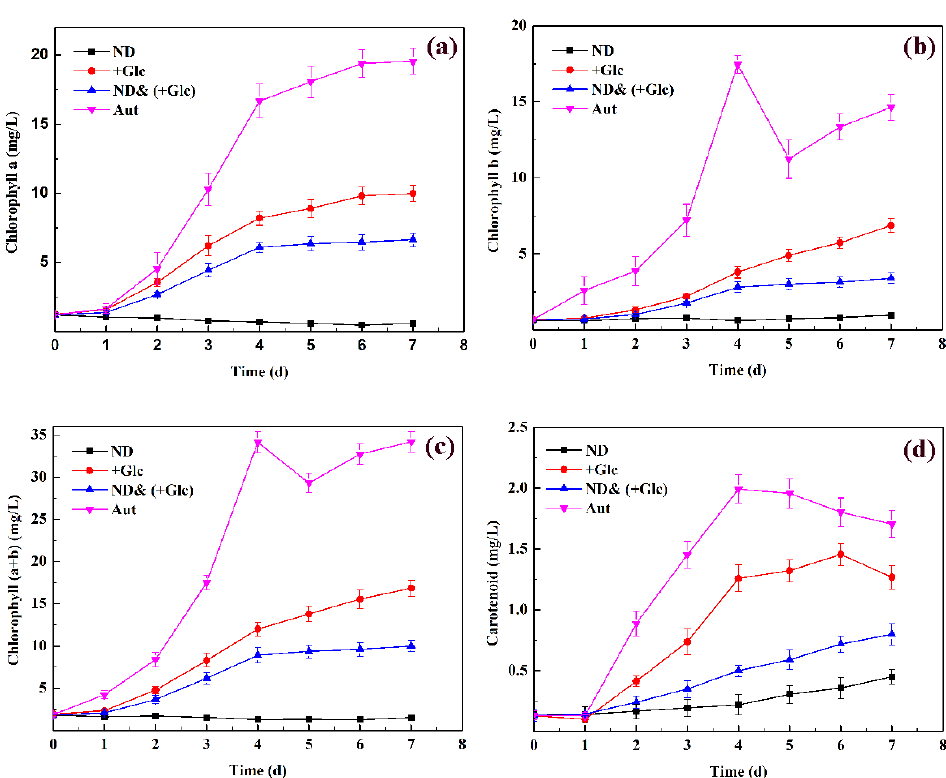
Figure 2. Changes in the pigment content in P. kessleri TY under different culture conditions: ( a ). the